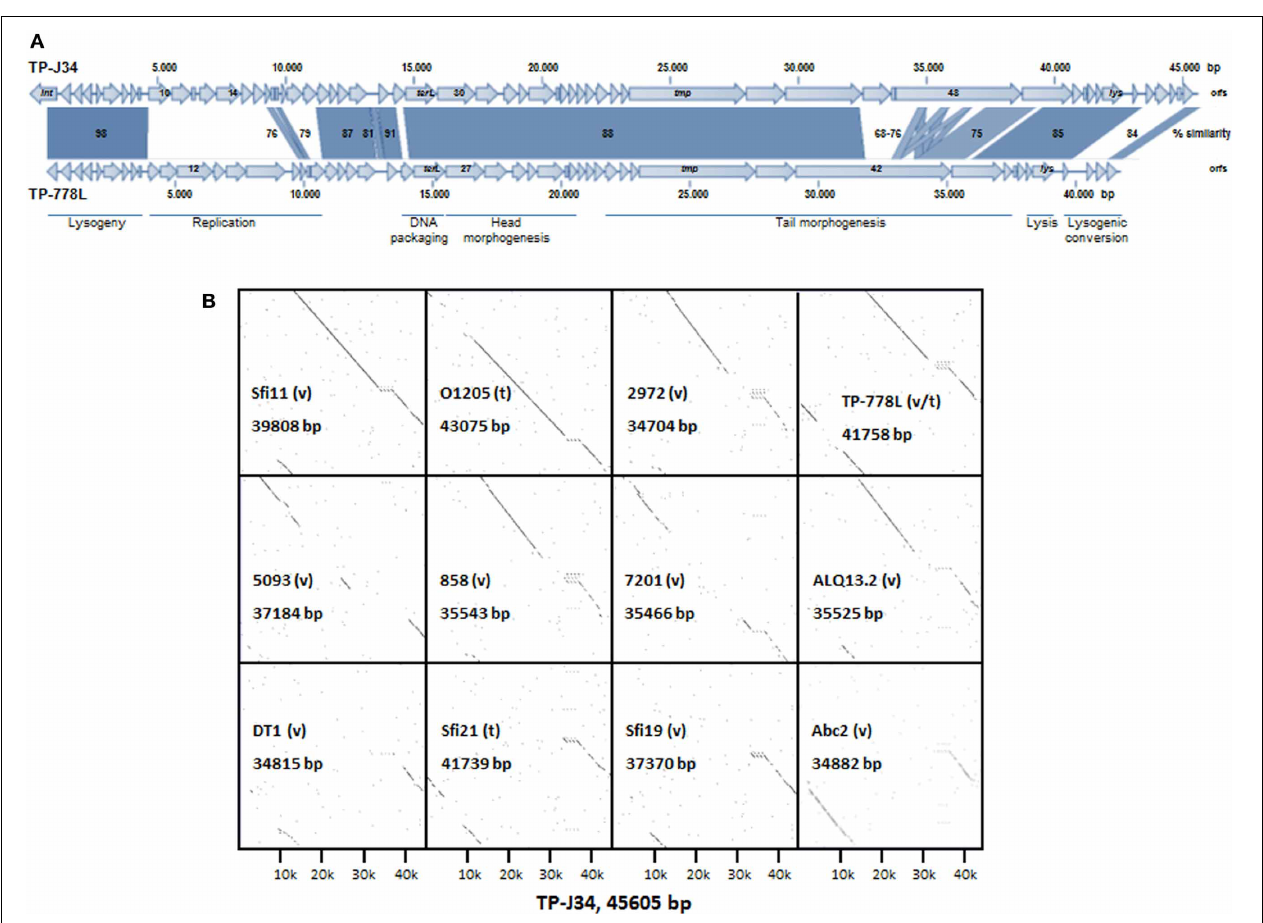
FIGURE 3 | (A) Alignment of gene maps and functional gene regions of TP-J34 and TP-778L. On the genetic maps, genes, and direction of transcription are indicted by arrows (very small genes are shown as boxes, the directions of transcription correspond to adjacent genes). Numbers or gene abbreviations refer to orf s or genes as listed in Tables 3 , 4 . A scale indicating nucleotide positions is shown above the TP-J34 map. Approximate positions of functional regions (modules) are indicated by horizontal bars